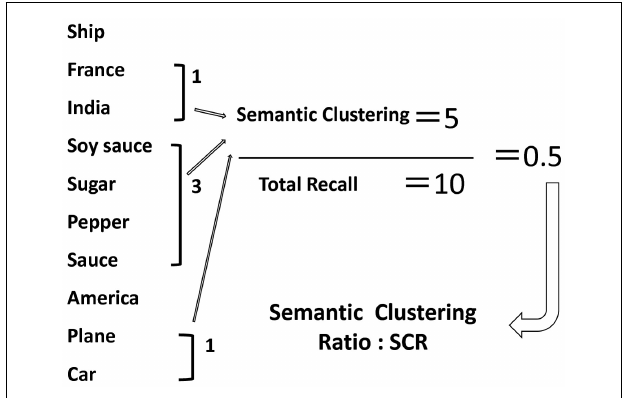
FIGURE 1 |An example of memory organization as assessed by the JapaneseVerbal LearningTest .The number of semantic categories (SCR) is counted when a separate word belonging to the same semantic category is recalled consequently.Thus, the SCR implicitly reflects the degree of memory organization. However, this index by itself can be affected by the total number of words recalled.Therefore, this study used the ratio of SCR vs. the total number of recalled words (SCR ratio) as an index of memory organization (see Materials and Methods).